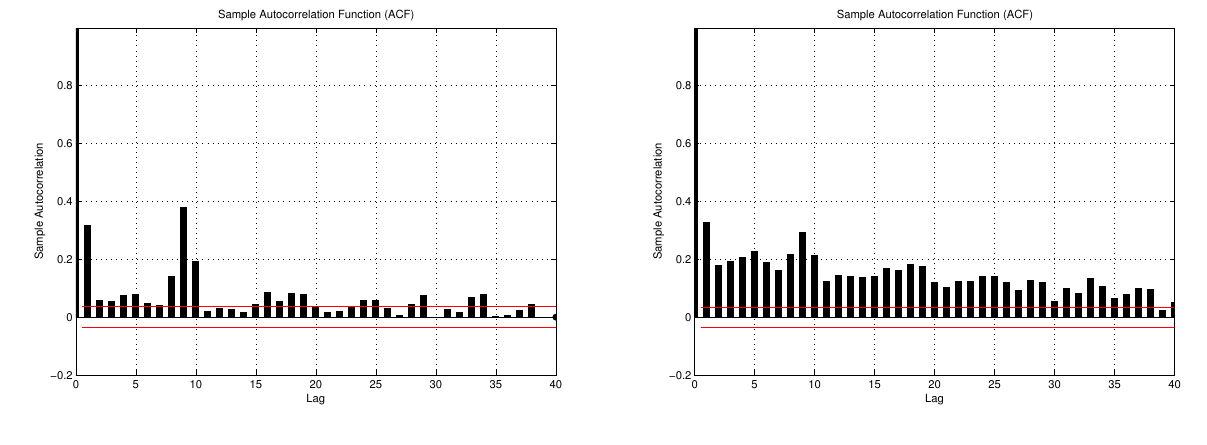
Figure 5. Sample autocorrelations for the squared ( left ) and absolute ( right ) residuals of the HAR model with leverage effects.